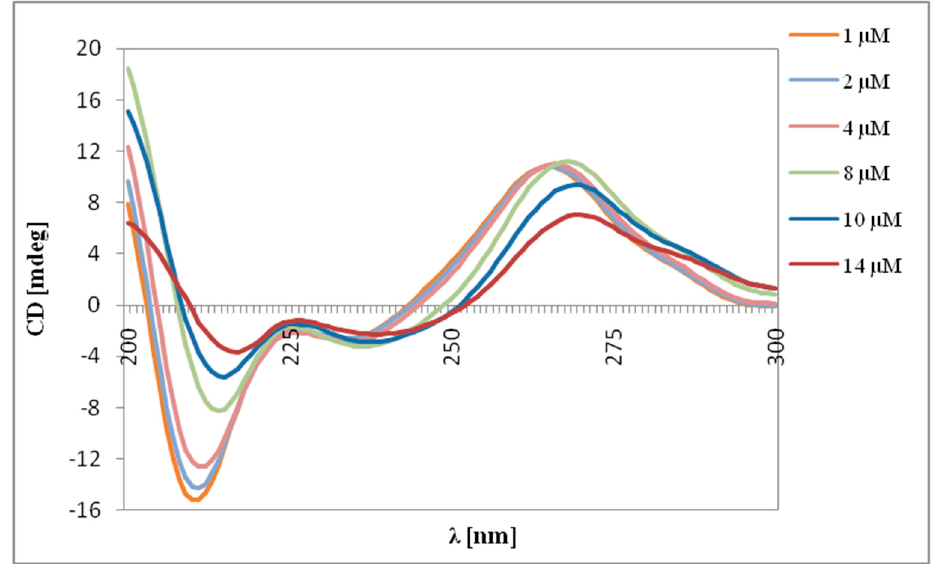
Figure 2. CD spectra of the Bcl-2 (2 μ M) in the presence of CBD-2 dendrimer (1–14 μ M) in 10 mmol/l phosphate buffer.